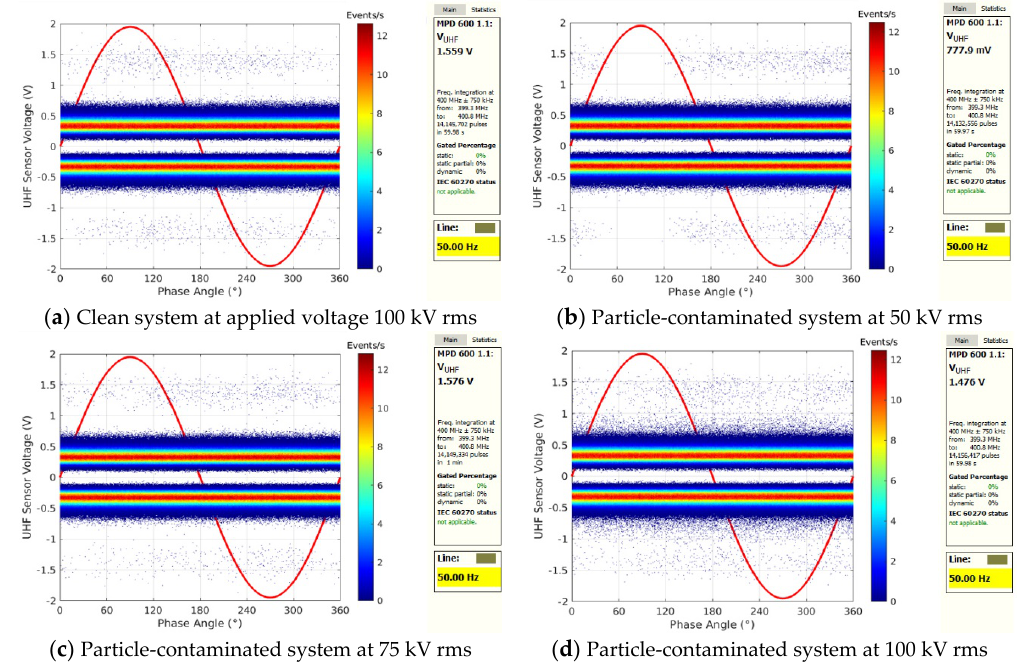
Figure 9. PD measurement of a gas insulated line demonstrator filled with 3 bar CO 2 measured using a capacitively coupled UHF sensor.